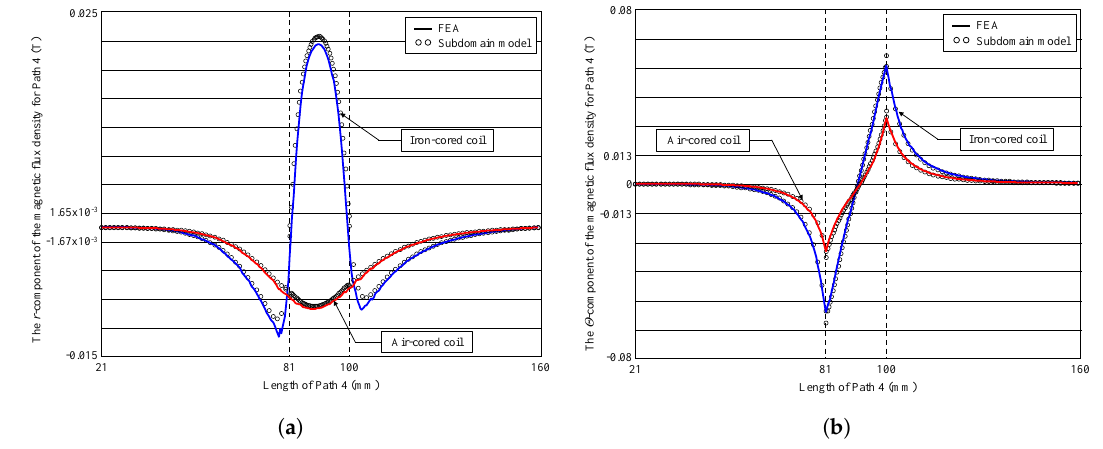
Figure 10. Waveforms of B for Path 4: ( a ) r - and ( b ) Θ -component.